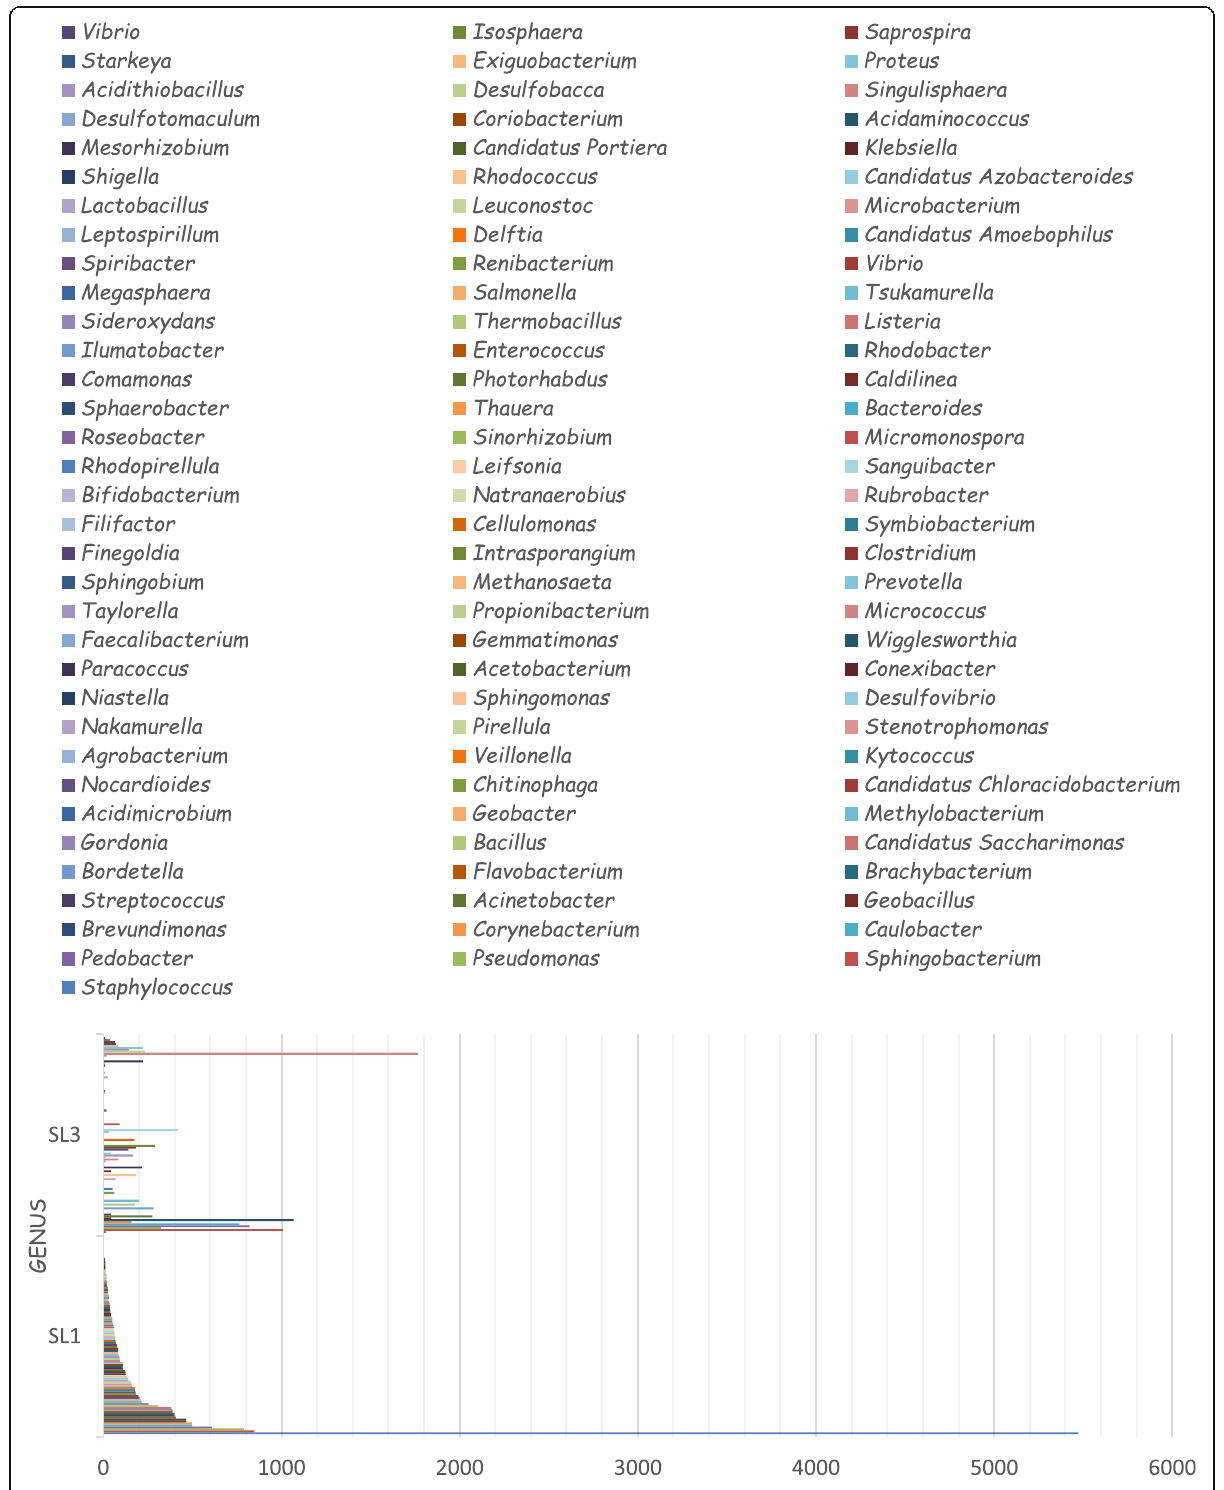
Fig. 5 Genus classification of SL1 and SL3 metagenomes. Unclassified reads were not used. Only genera with ≥ 10 sequence reads were used for the